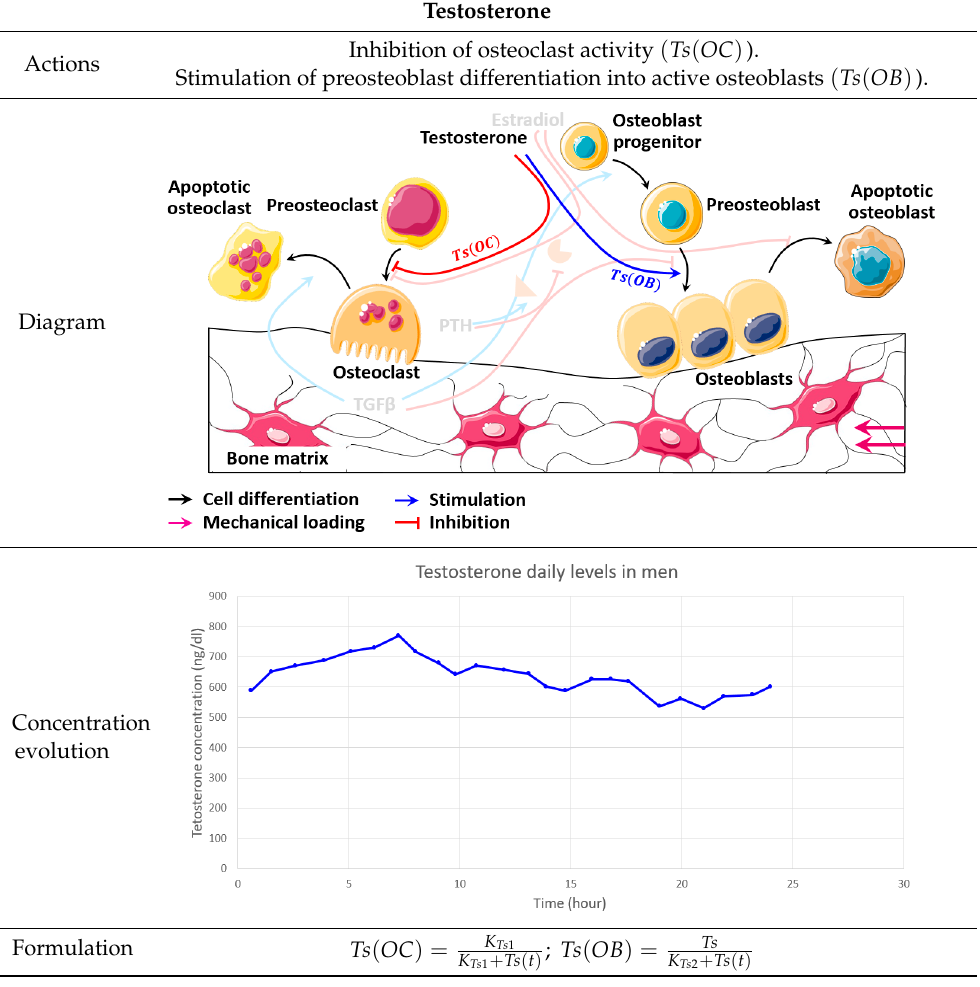
Table 4. Testosterone actions and their mathematical formulation.